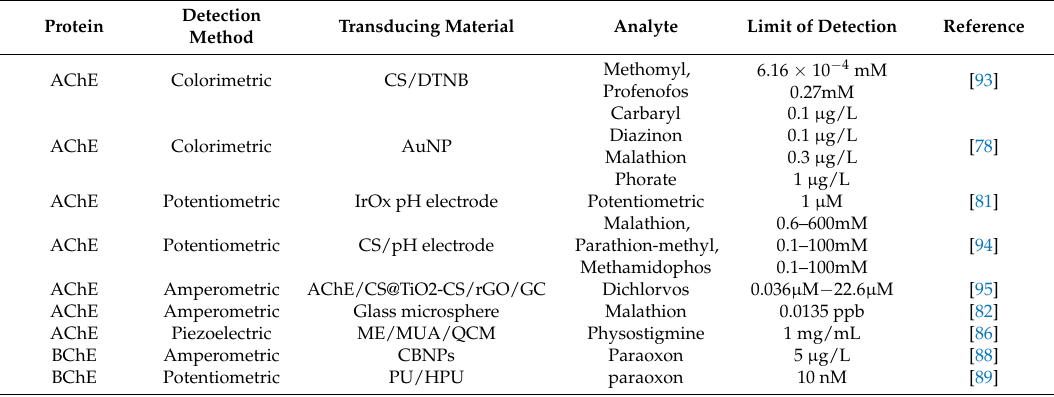
Table 2. Summary of the various methods of